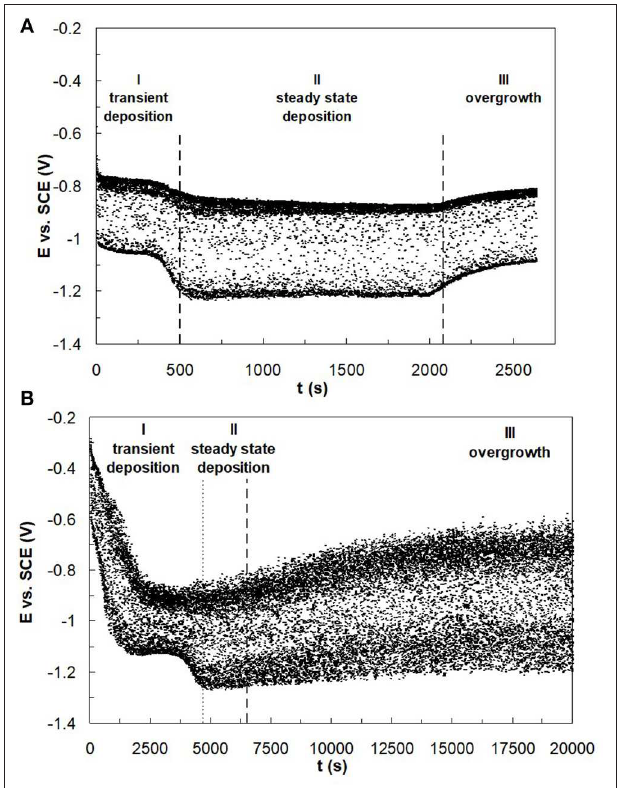
FIGURE 9 | Typical E-t dependence for (A) Co–W and (B) Fe–Co–W nanowire deposition reflecting nanowire growth into the pores of polycarbonate membrane at 23 ◦